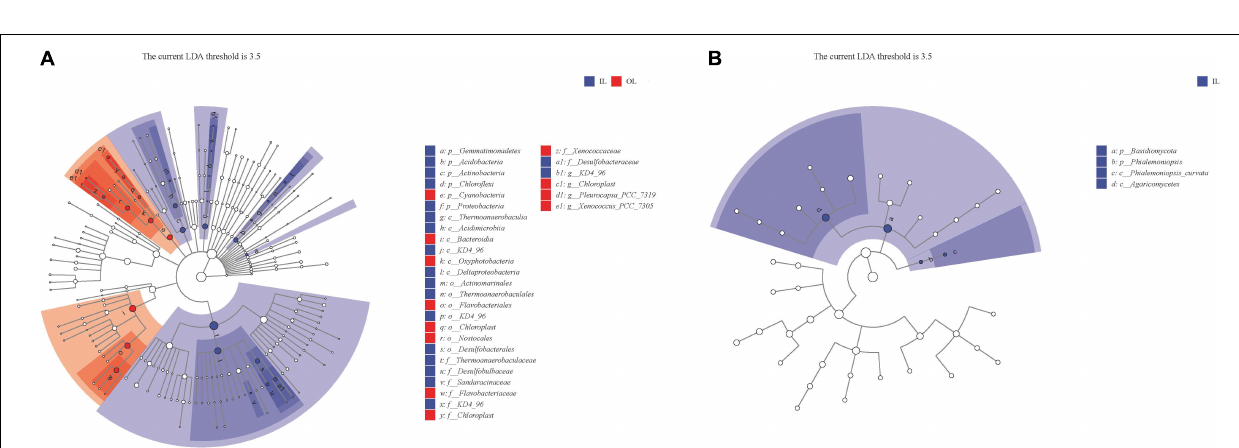
Frontiers in Microbiology |